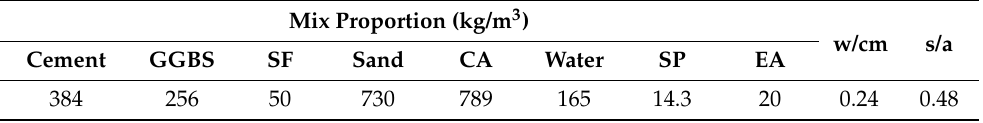
Table 1. Mix proportion of self-compacting concrete